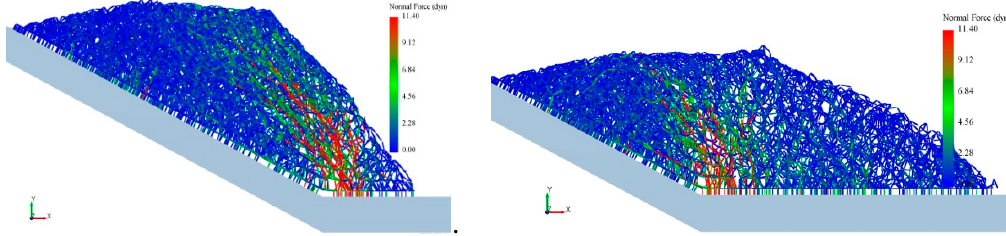
Figure 13. Diagram of normal force of wet soil sliding at the slope foot ( γ = 0.1 J/m 2 , d = 1 mm).